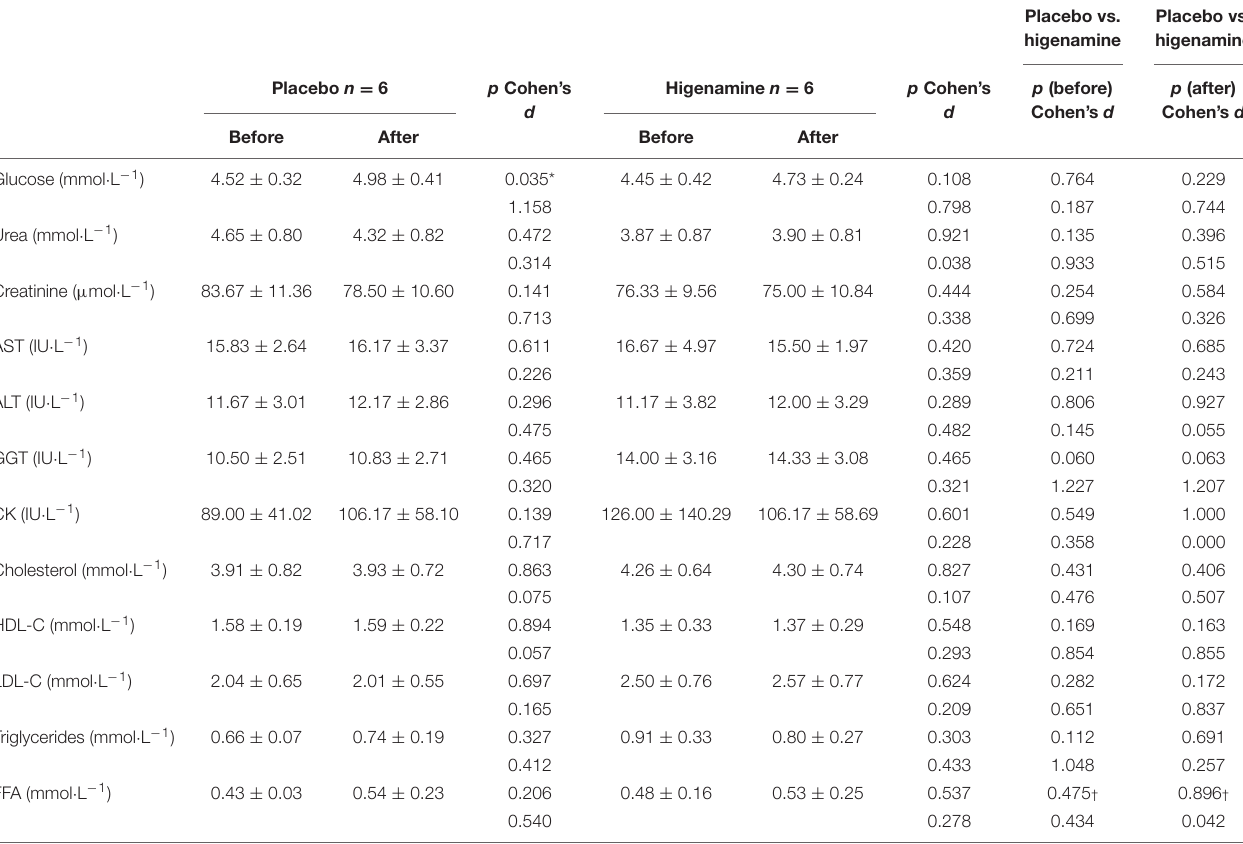
TABLE 3 | Metabolic parameters in placebo and higenamine groups before and after the treatment.